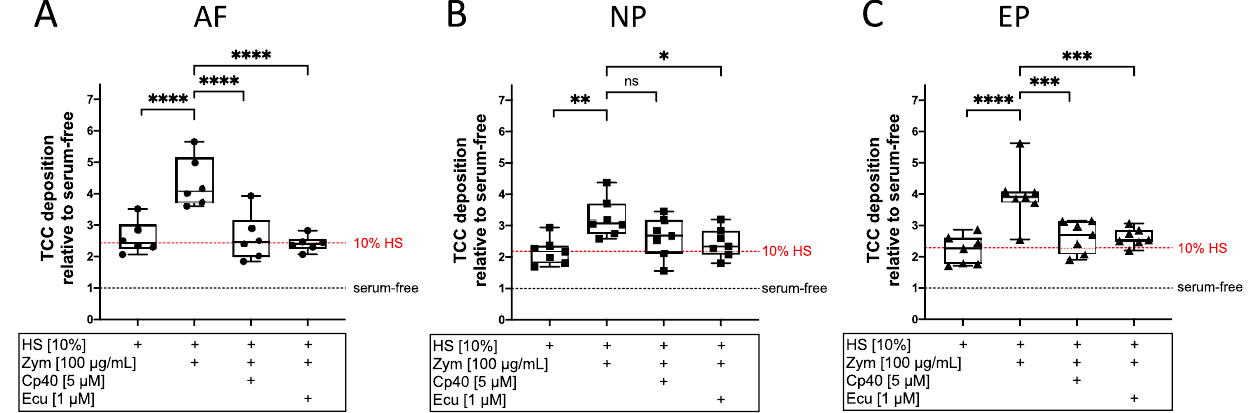
Figure 3. Investigation of complement inhibition regarding TCC deposition. TCC deposition on isolated ( A ) annulus fibrosus (AF), ( B ) nucleus pulposus (NP), and ( C ) endplate (EP) cells after 2 h stimulation with 10% human serum (HS) alone or with zymosan (100 µg/mL; Zym) with or without complement inhibitor Cp40 (5 µM) or eculizumab (1 µM; Ecu) analyzed via cell-based ELISA. Serum-free cell cultures served as the control group. Values of samples were normalized by respective values of the control group. Dotted lines represent the median TCC deposition of serum-free controls (black) and 10% HS (red). The results are presented as box-and-whisker plots with median ± interquartile ranges ( n = 6–7 donors per group). Significant differences are depicted as: * p < 0.05; ** p < 0.01; *** p < 0.001; **** p < 0.0001; ns: not significant. One-way ANOVA was